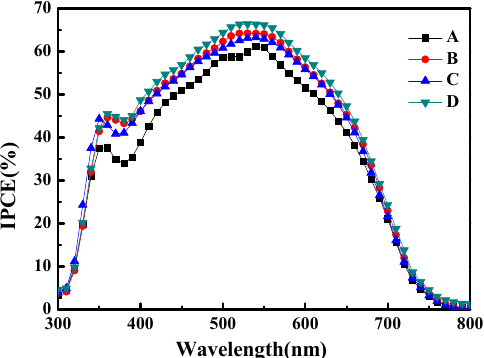
Figure 5. IPC characteristics of the DSSCs. Curves from A to D represent incident monochromatic photon-to-current conversion efficiency of bare glass ( sample A ), PDMS/glass ( sample B ), flat PMMA/PDMS/glass ( sample C ) and subwavelength moth-eye structured PMMA/PDMS/glass ( sample D ), respectively.